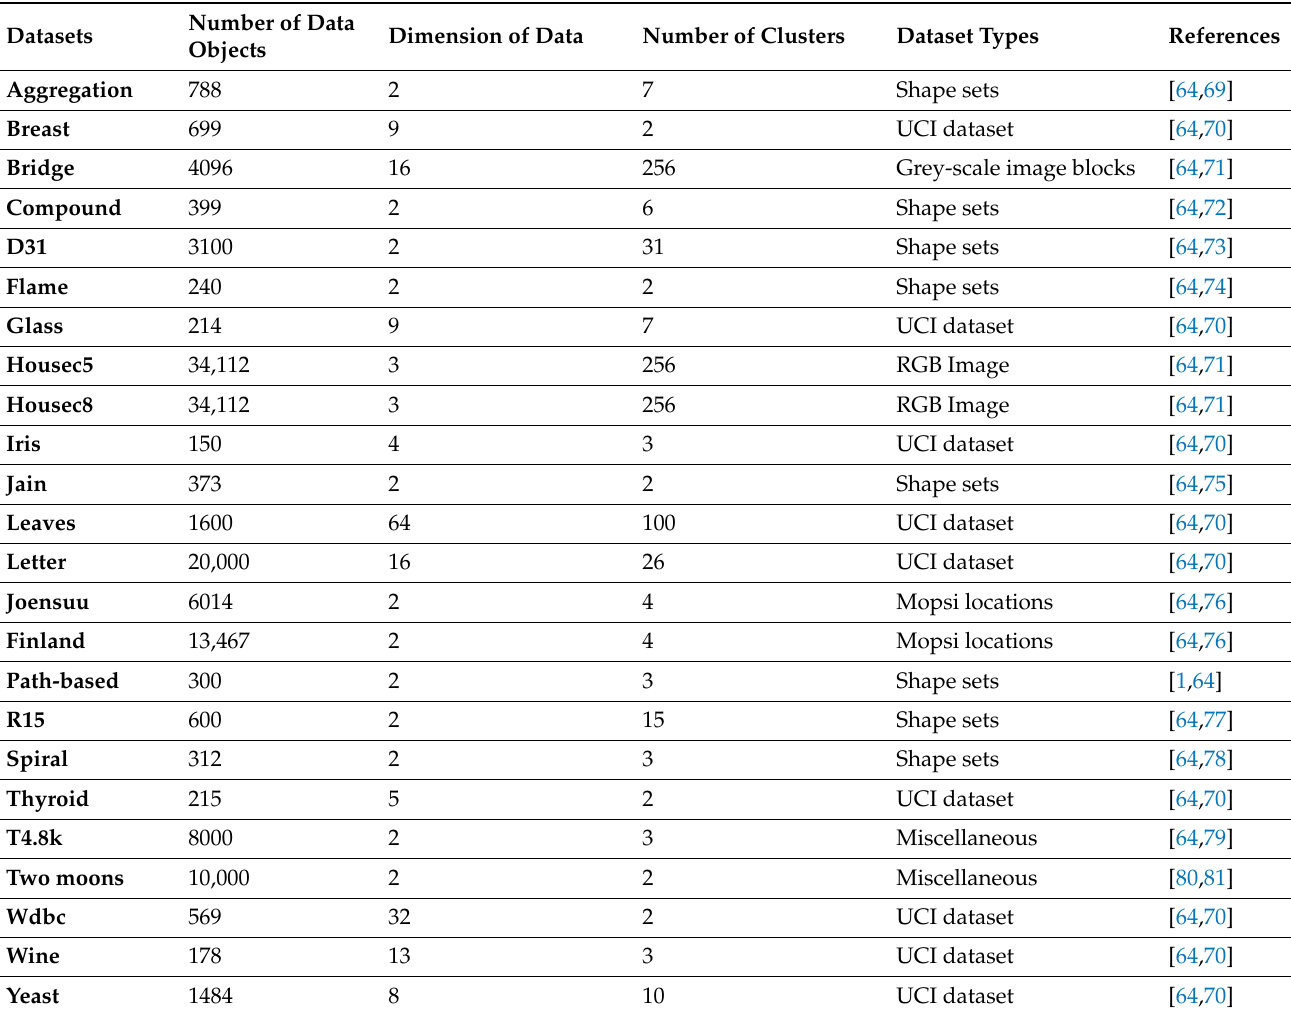
Table 3. The characteristics of the 24 real-life